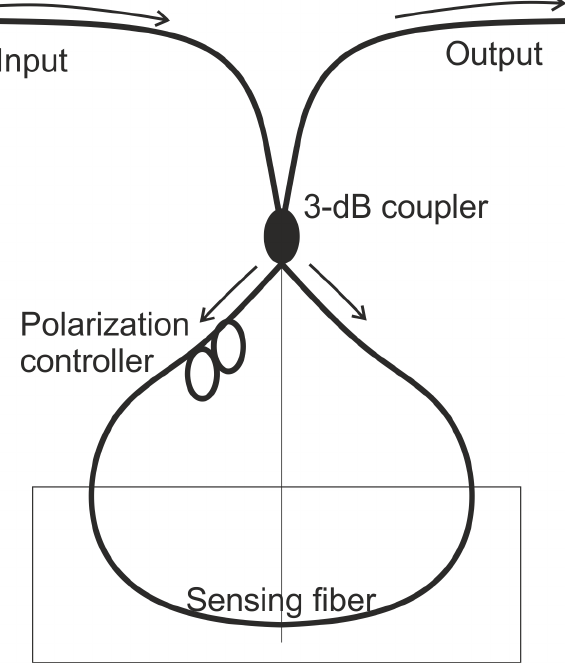
Figure 7. Principle of SI (based on reference [53]).